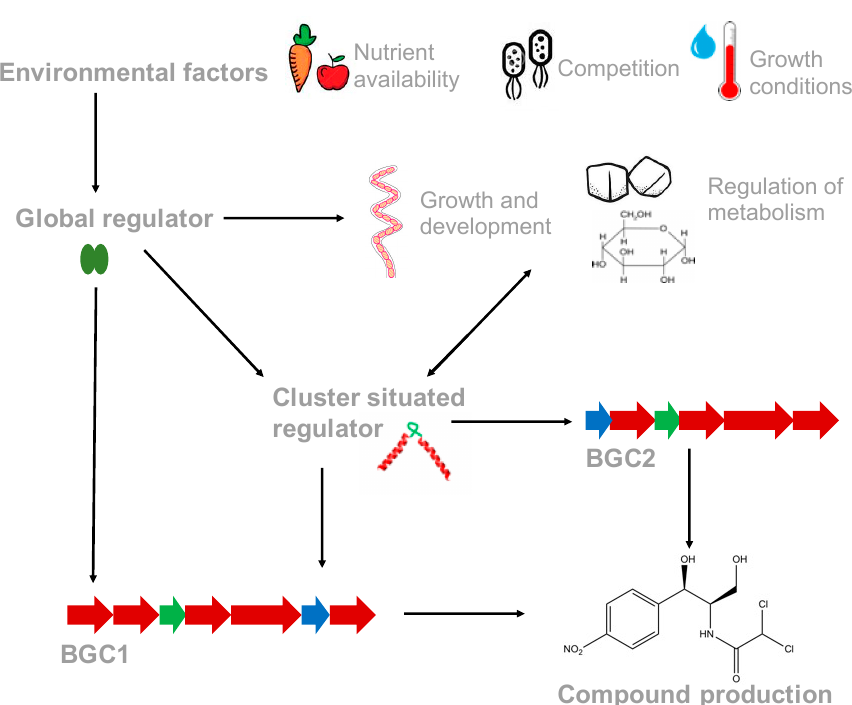
Figure 1. Regulation of secondary metabolite gene expression is controlled by cluster situated regulators (CSRs), which can be controlled by binding of pathway products, and global regulatory systems, which are influenced by external environmental factors, such as nutrient availability. Global regulators coordinate primary and secondary metabolism with growth and development. Global regulators can control the expression levels of CSRs, indirectly a ff ecting BGC expression, or bind to elements within BGCs and directly control expression. Some CSRs are also influenced by (and / or can influence) primary metabolism, growth and development. Additionally, some CSRs can cross-regulate the expression of other BGCs in the genome, thereby controlling the levels of multiple secondary metabolites. Regulator Table 1. Comparison of the various coordinate regulatory systems described in this review.